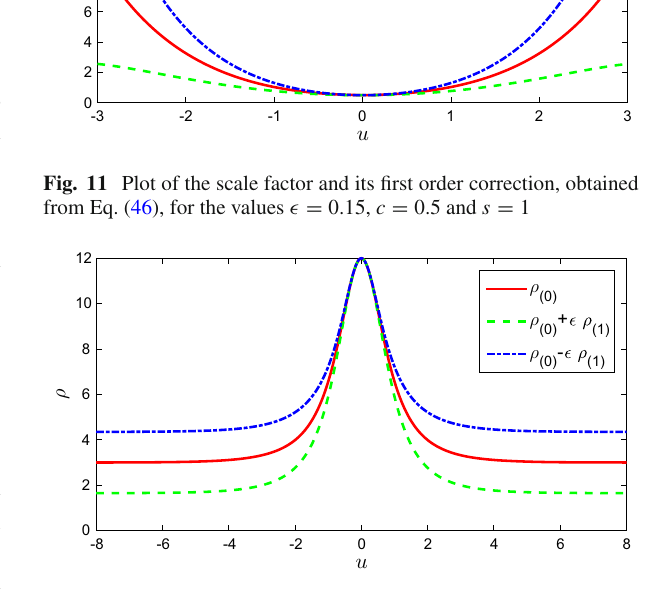
Fig. 12 Plot of energy density ρ and its first order correction obtained from Eq. (46), for the parameter values (cid:9) = 0 . 15, c = 0 . 5 and s = 1